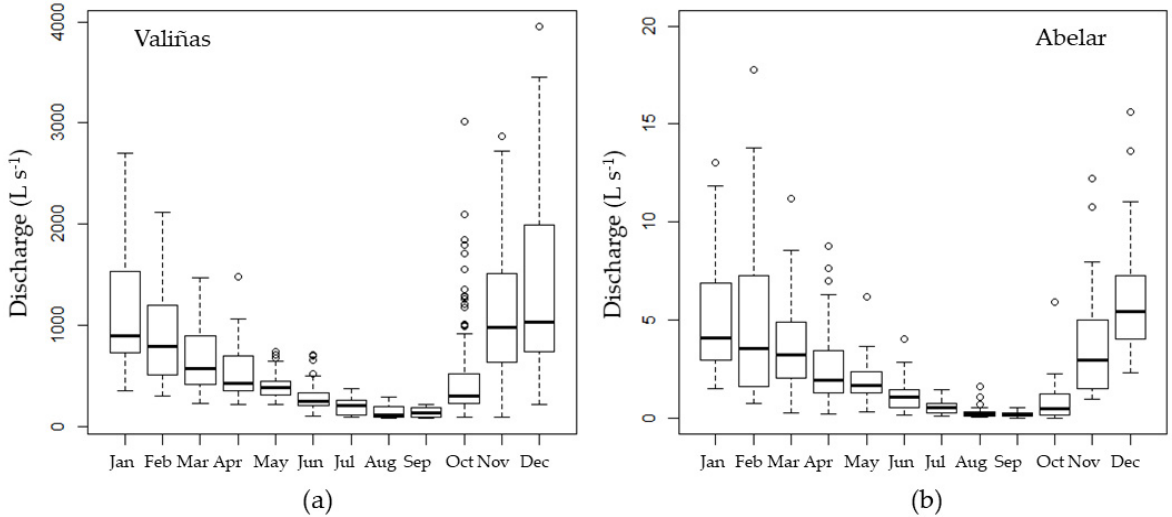
Figure 4. Boxplots of discharge by month for the ( a ) Valiñas and ( b ) Abelar catchments over the studied period (2003–2016 in Valiñas and 2007–2016 in Abelar). The horizontal middle line indicates the median; the lower and upper edges of the box indicate the 25 and 75% points, respectively; the whiskers indicate the main body of data (without outliers); circles indicate outliers.